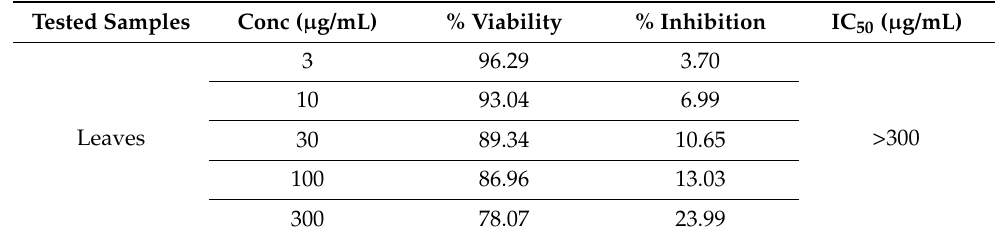
Table 3. The % Viability and inhibition of B. hirtum essential oil on the normal breast cell line MCF-10A. Tested